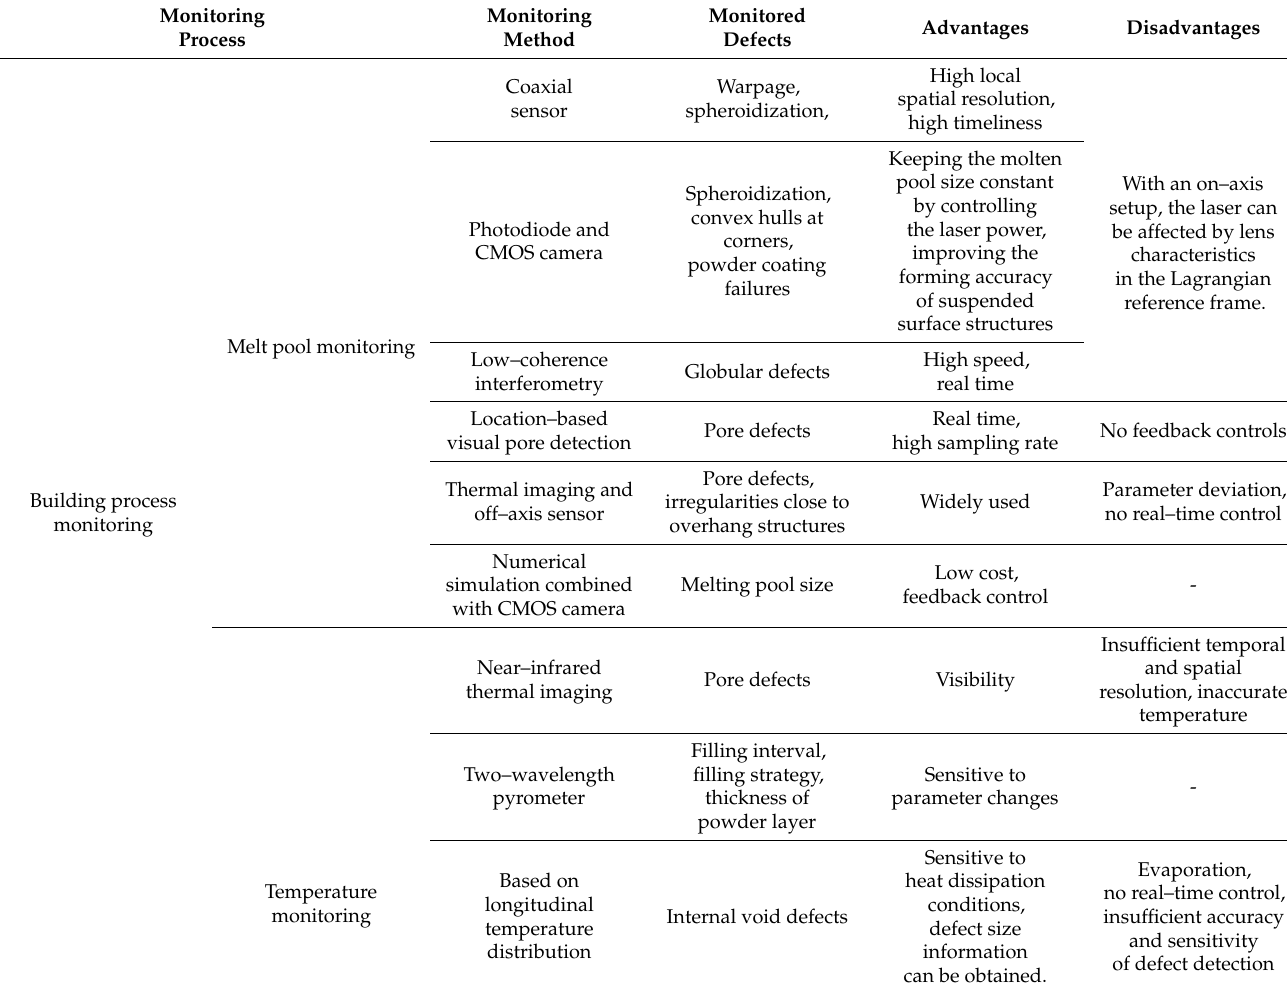
Table 3. Reveals building process